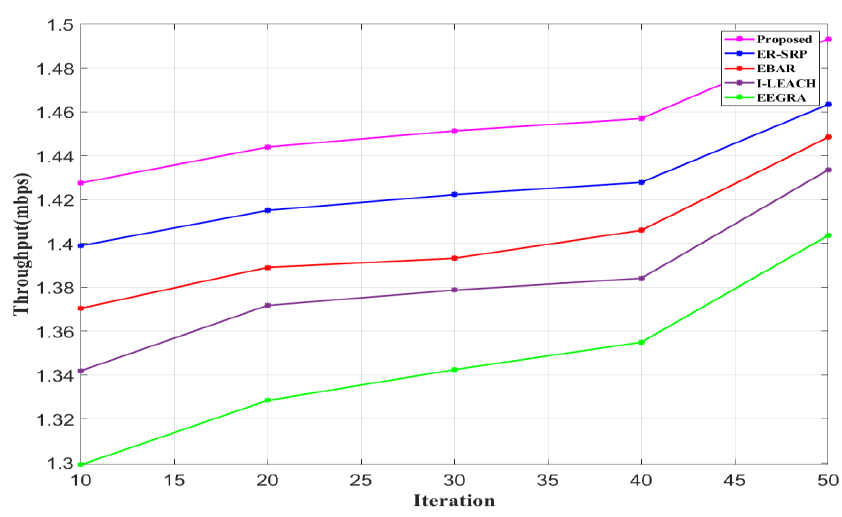
Figure 12. Comparison of